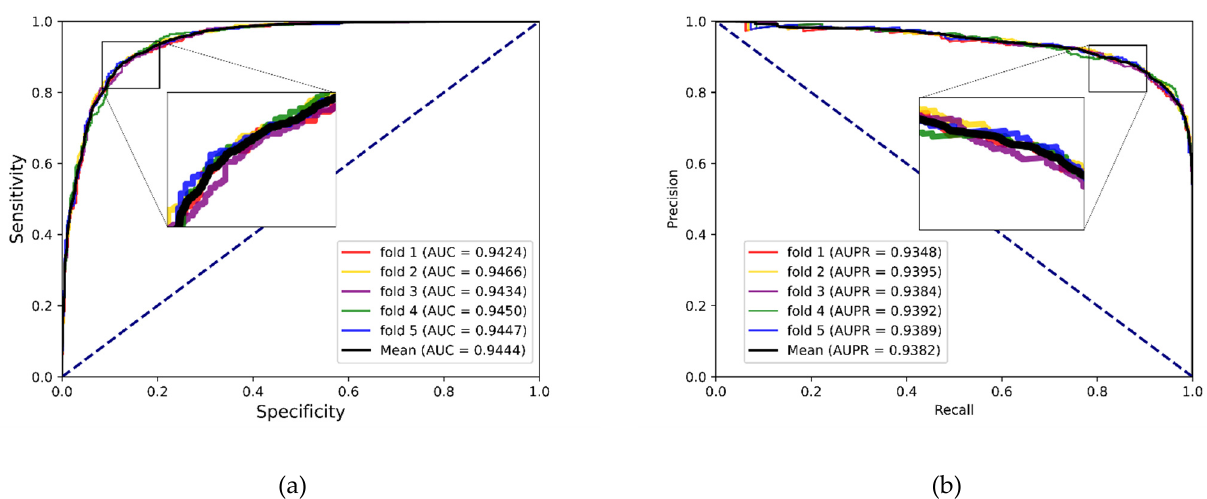
Figure 5. (a)The ROC curves of the result on the RNAInter datasets. (b) The PR curves of the result Figure 5. ( a ) The ROC curves of the result on the RNAInter datasets. ( b ) The PR curves of the result on the RNAInter datasets. on the RNAInter